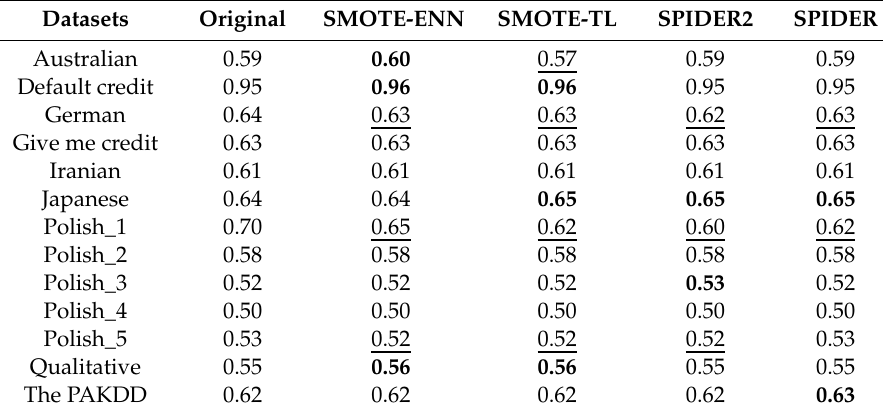
Table 11. AUC for HACT classifier after hybrid